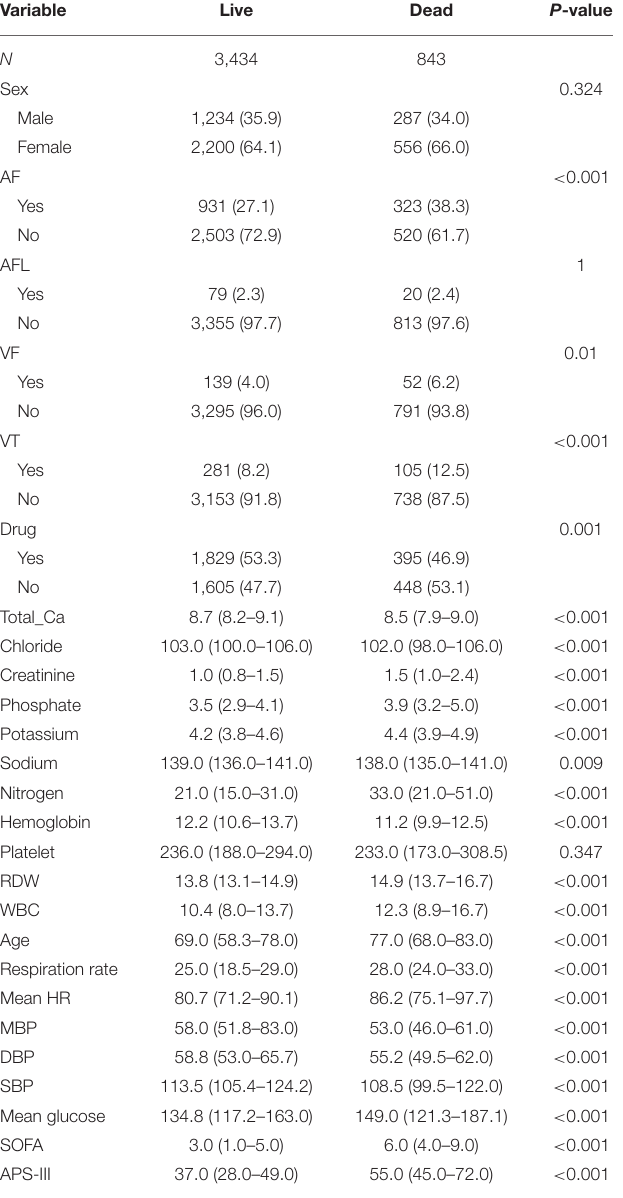
TABLE 1 | Baseline characteristics of patients in the study.